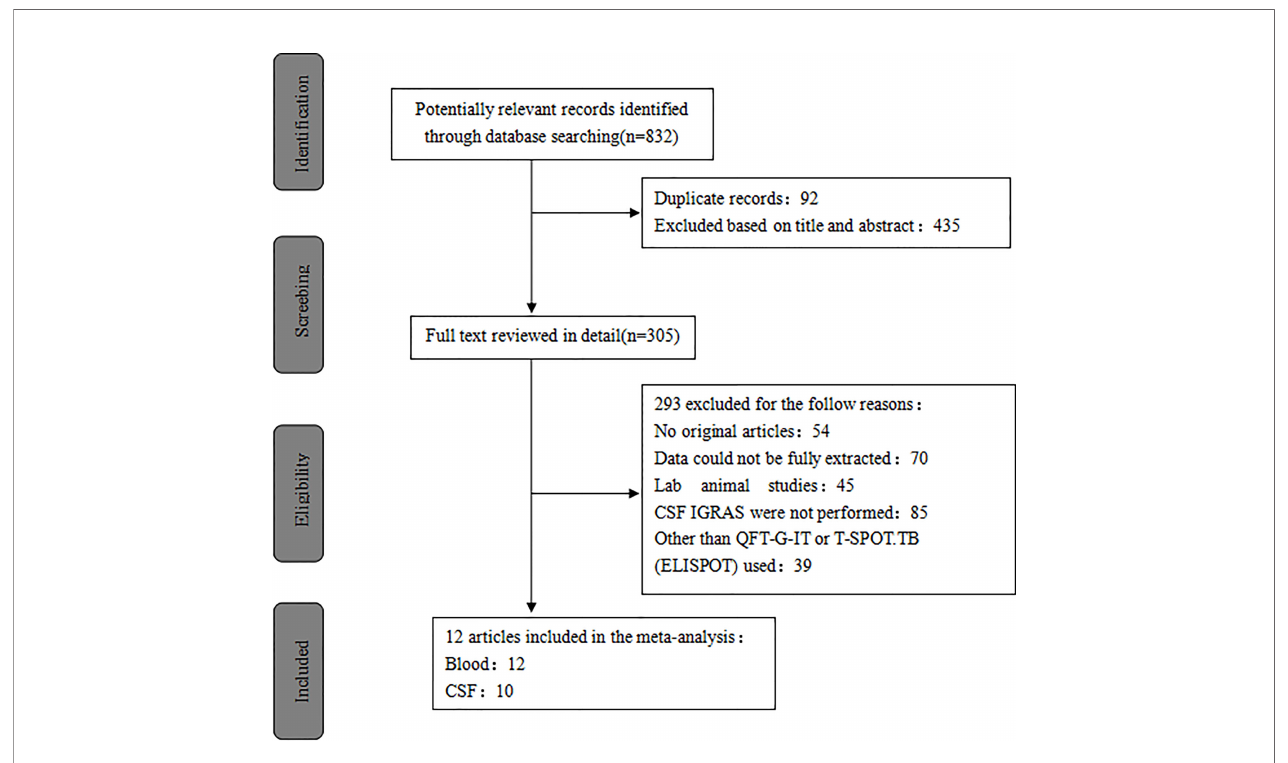
FIGURE 1 | The study selection process fl owchart.